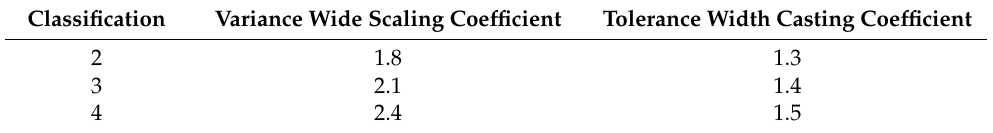
Table 1. Classification criteria for different